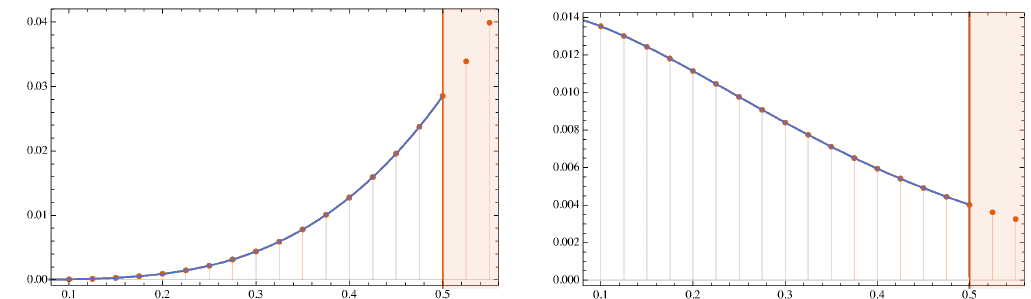
Figure 5 . Real and imaginary part of the lateral Borel summation for the grand potential (dots) compared to the small-charge expansion and the exponential corrections from worldline instantons (continuous line) as function of mr . The two approaches agree completely at the level of resolution of our numerical computation. The small-charge expansion is not convergent in the shaded